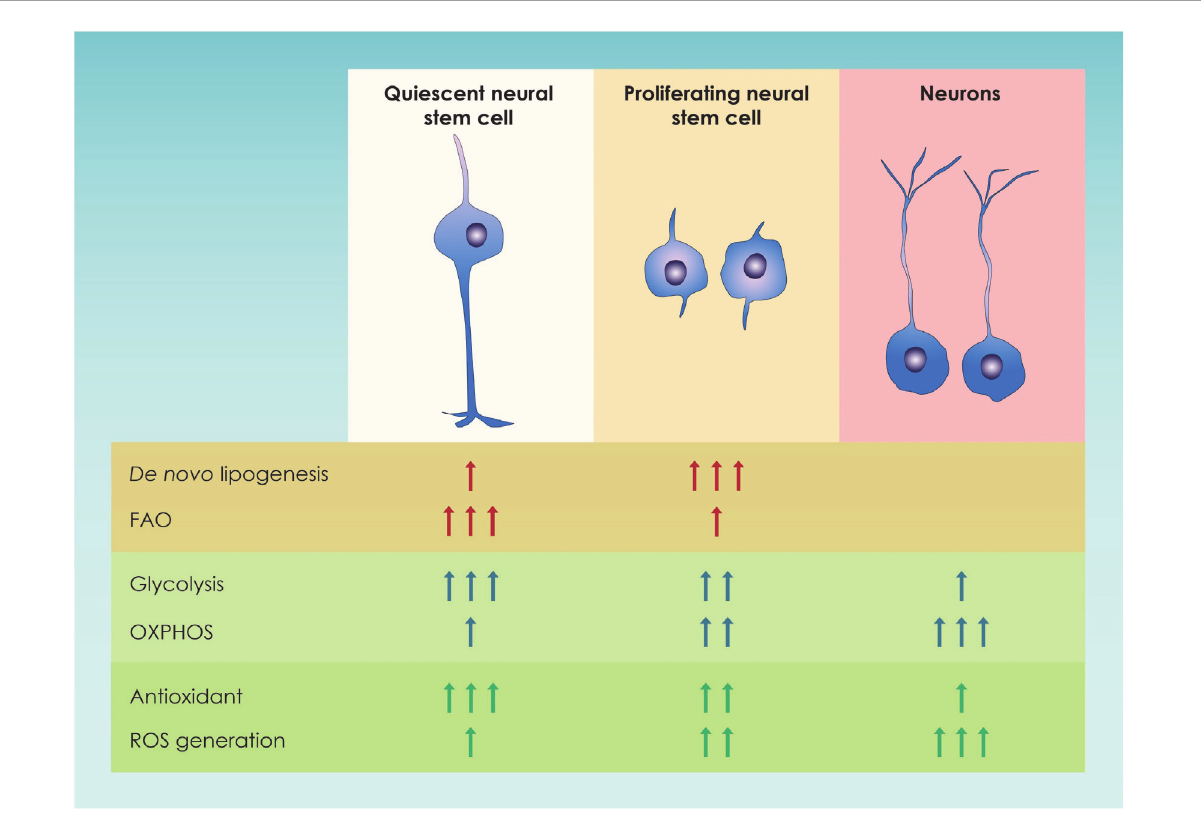
FIGURE2 Graphic illustration of the main metabolic pathways of neural stem cells. In this figure the major changes in metabolic pathways occurring in quiescent and proliferating neural stem progenitor cells (NSPCs) as well as in immature neurons in the adult dentate gyrus and the developing forebrain are shown; FAO, Fatty Acid Oxidation; OXPHOS, Oxidative Phosphorylation; ROS, Reactive Oxygen